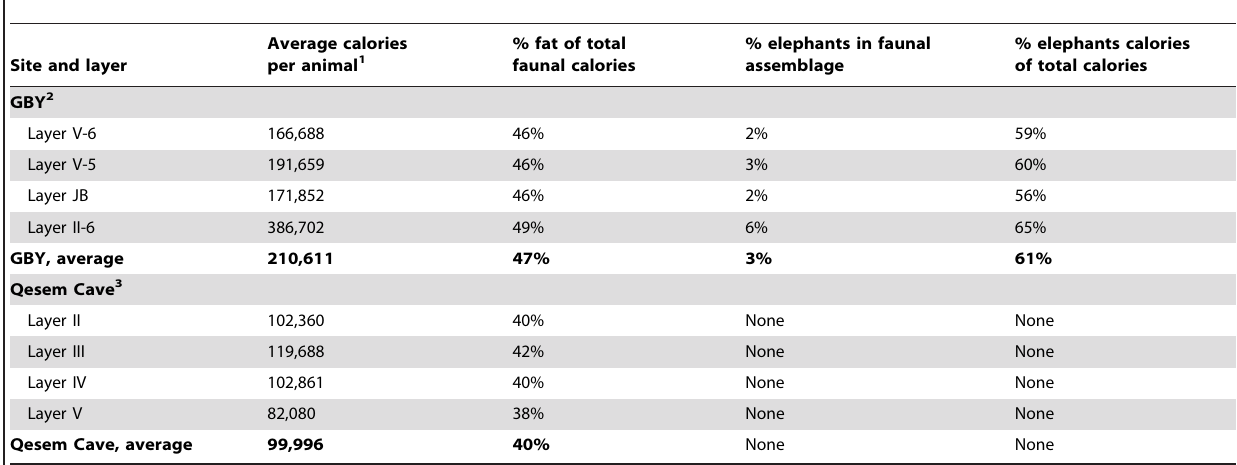
Table Notes. 1 For missing information, data of representative animals of similar weight was considered ([87]: Appendix); see Table S3 and Table S4 for details. 2 Rabinovich and Biton ([26]:4, Table 2); data based on NISP (see Table S3 for details by size